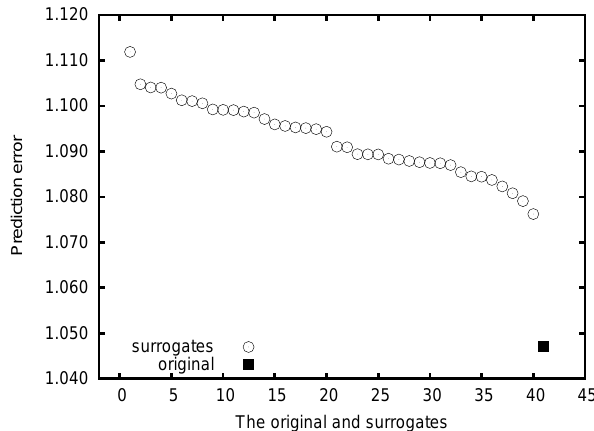
Fig. 15. The plot of the prediction errors for m = 14 ,τ = 1 for the surrogates (denoted by circles) and that of the original series (de- noted by filled square), showing the determinism in the time series. The significance of difference S = 4 . 15.